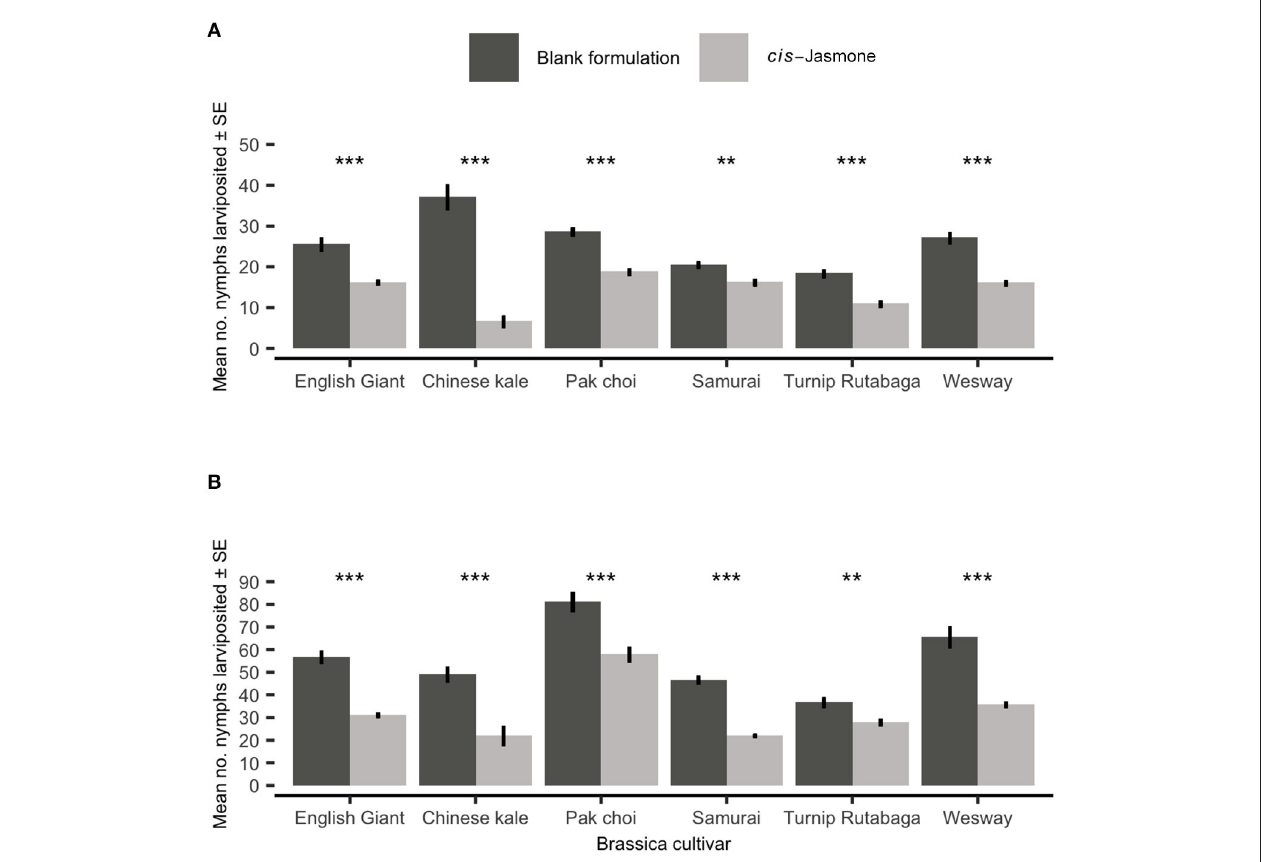
FIGURE 2 | Myzus persicae larviposition (Mean ± SE) after (A) 48h and (B) 96h in clip cages on six brassica cultivars ( n = 10) treated with cis- jasmone or blank formulation (control). Asterisks denote differing levels of statistical significance: ** < 0.01 and *** < 0.001 (generalised linear models with quasi-Poisson probability